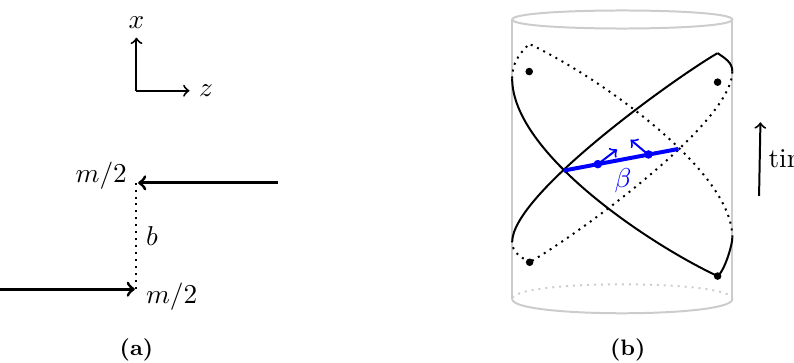
Figure 4. Relation between impact parameter and angular momentum in the Regge limit. (a) In flat space, a pair of massless particles with center-of-mass energy m and transverse separation . (b) In a holographic CFT , the Regge limit of the b carries total angular momentum J = m b d 2 four-point function localizes along two null sheets. They intersect in the transverse hyperbolic space H d − 1 depicted by the blue line. A pair of massless particles with center-of-mass energy ∆ /R AdS separated in H by geodesic distance βR carries total angular momentum J = ∆ tanh β d − 1 AdS 2